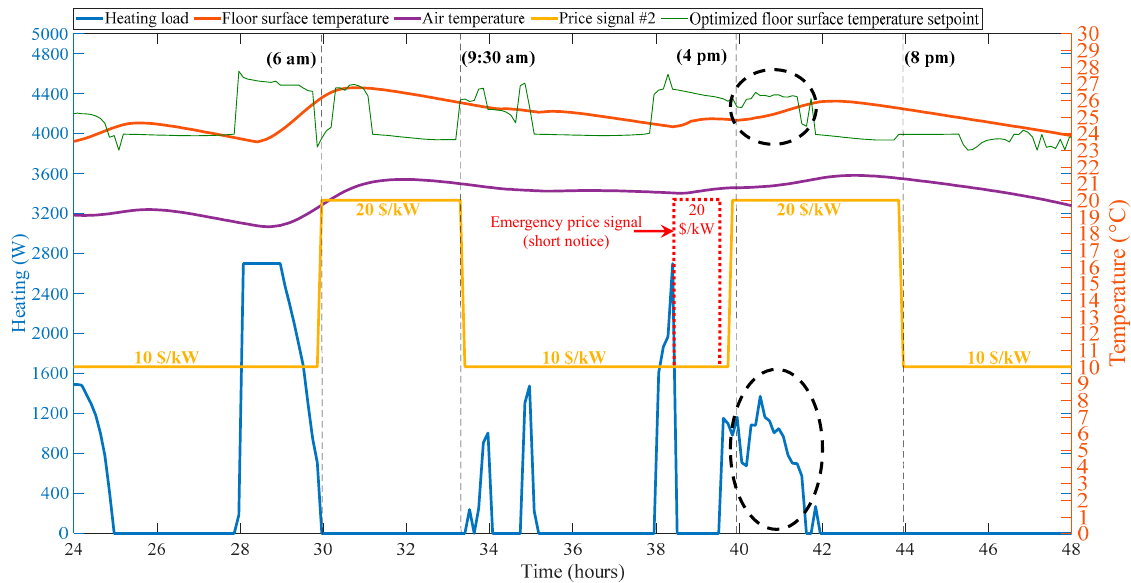
Figure 17. Unexpected change in the price signal.